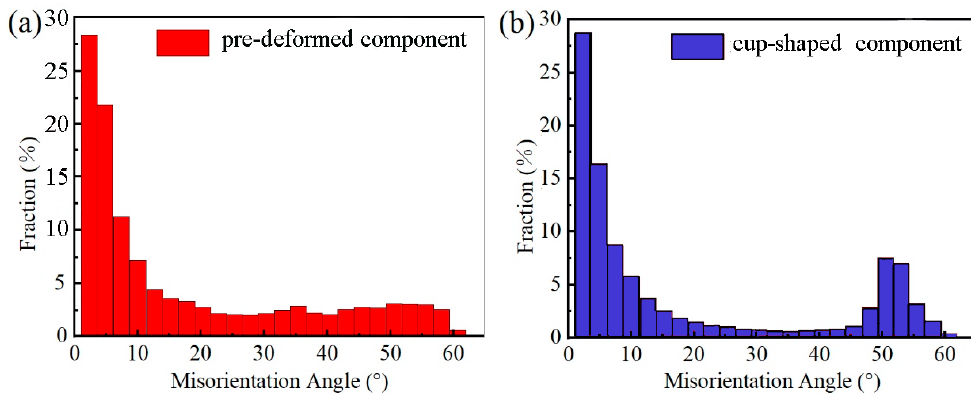
Figure 5. Distribution map of misorientation angle of the deformed structures. ( a ) pre-deformed